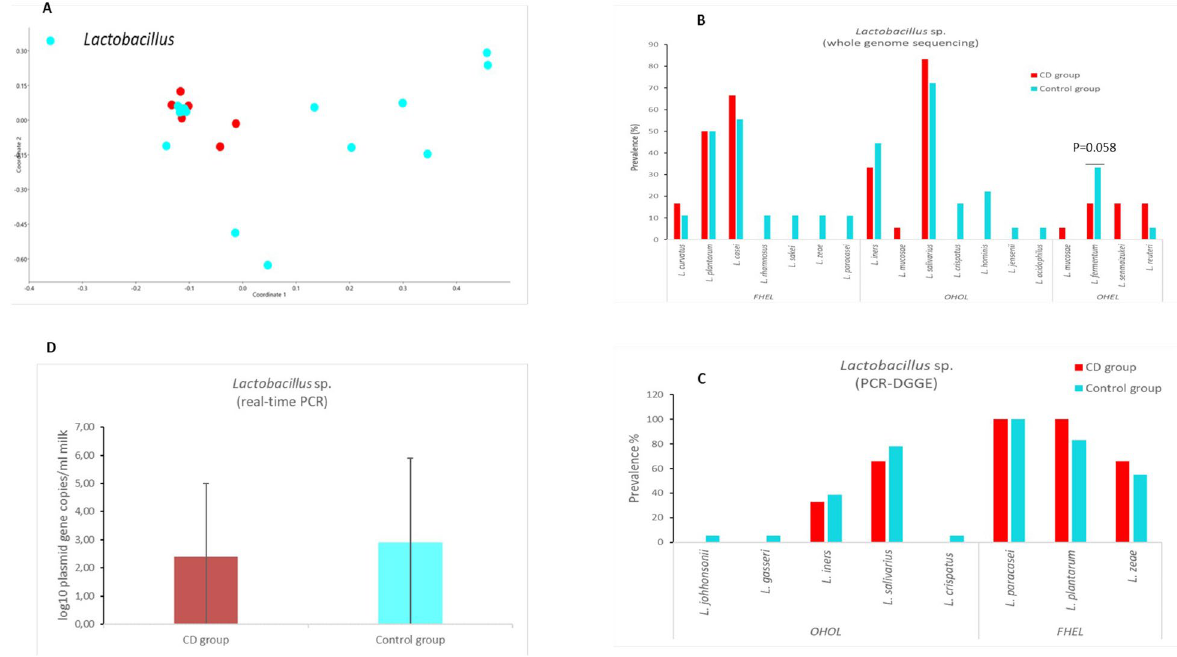
Figure 2. ( A ) Principal coordinate analysis (PCoA) of lactobacilli communities in studied samples. The plot demonstrates different clustering of different breast milk specimens [CD group (red) versus control group (blue)]. Prevalence (%) of different Lactobacillus sp. in breast milk samples according to whole genome sequencing (B) and denaturing gradient gelelectrophoresis (C) methods. FHEL facultative heterofermentative lactobacilli, OHOL obligate homofermentative lactobacilli, OHEL obligate heterofermentative lactobacilli. (D) Total counts (log10plasmid gene copies/ml milk) of Lactobacillus sp. in breast milk samples of CD and control groups by real-time PCR (mean ±